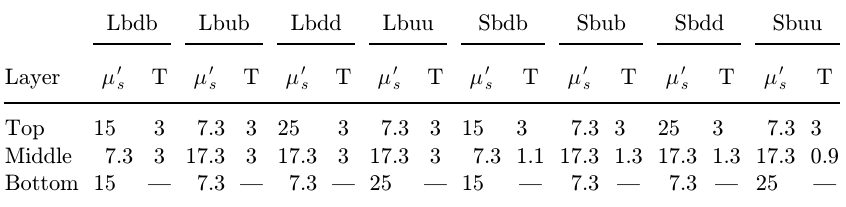
Table 3. (cid:1) 0 s and the thickness of three-layer models.